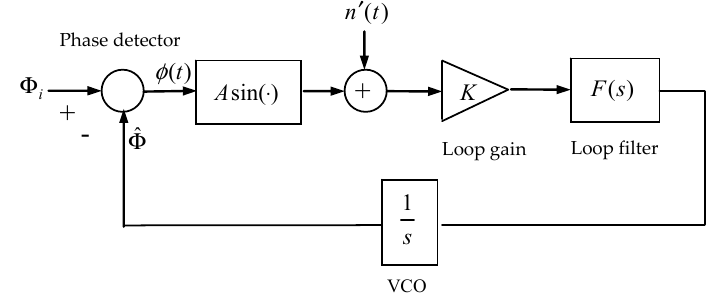
Figure 1. Mathematical block diagram of the phase-locked loop (PLL). The basic PLL configuration contains a phase detector (PD), for detecting the phase error between the output and the input through feedback system; a loop filter; and a voltage-controlled oscillator (VCO). The loop filter F ( s ) is usually a low-pass filter used to suppress the noise and high-frequency signal components from the phase-detector / delay discriminator and provide a dc-controlled signal for the VCO [1–3].